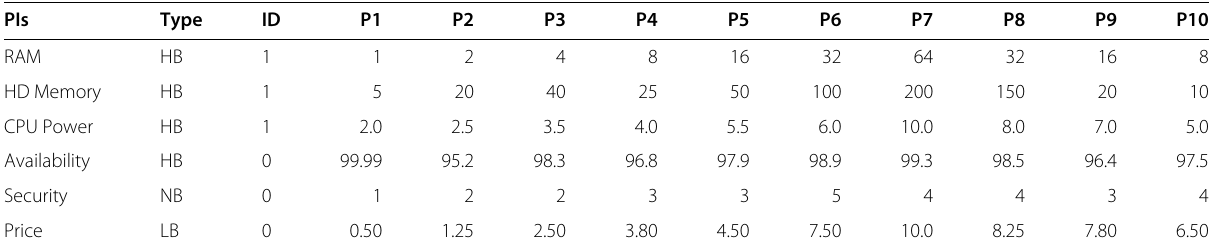
Table 6 Simulated CPs database with their